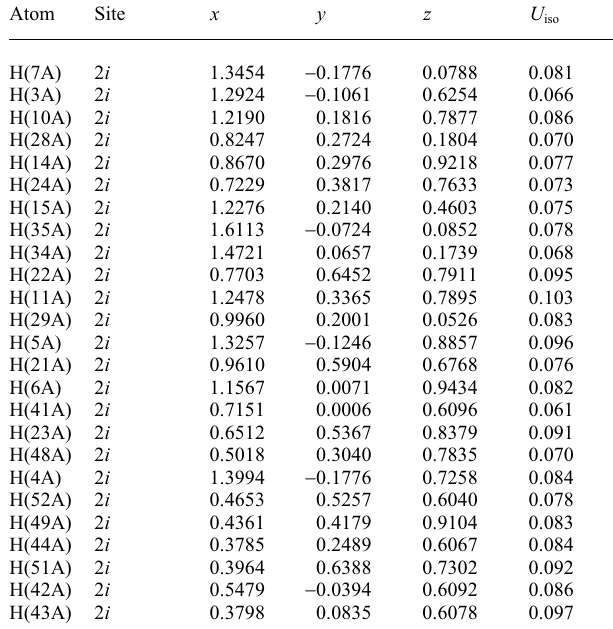
Table 1. Data collection and